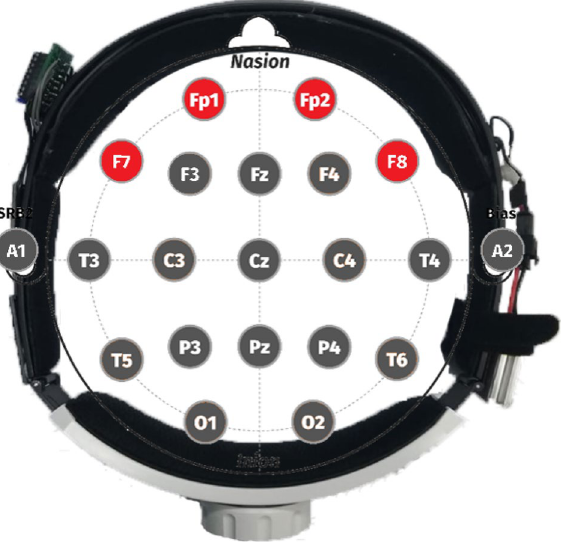
Figure 8. The Schematic positions of fNIRS optodes in the international 10–20